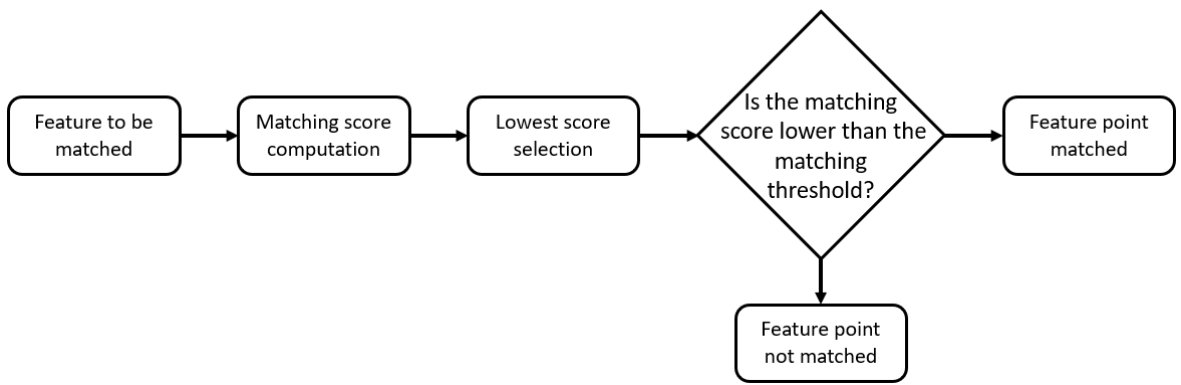
Figure 7. The feature matching